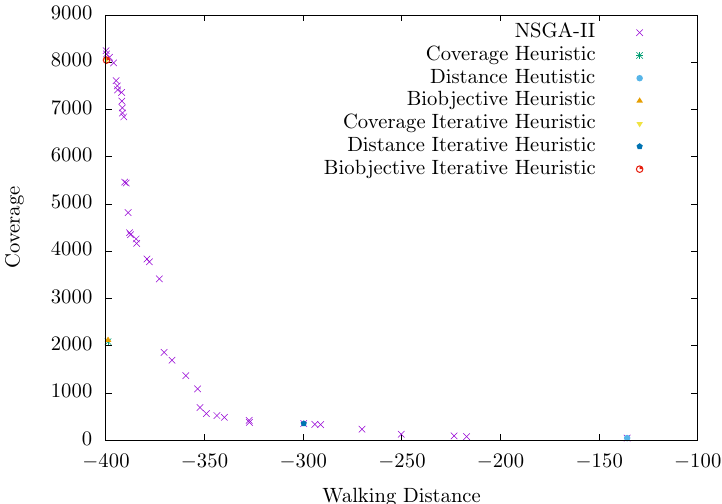
Figure 9. NSGA-II’s Pareto front and heuristic algorithms’ solutions for LU2. The higher the value on the x axis (moving towards the right), the better the distance objective is. The higher the value on the y axis, the better the user coverage objective is. Table 8. Comparing best results from each algorithm categories in LU2 instance. Algorithm